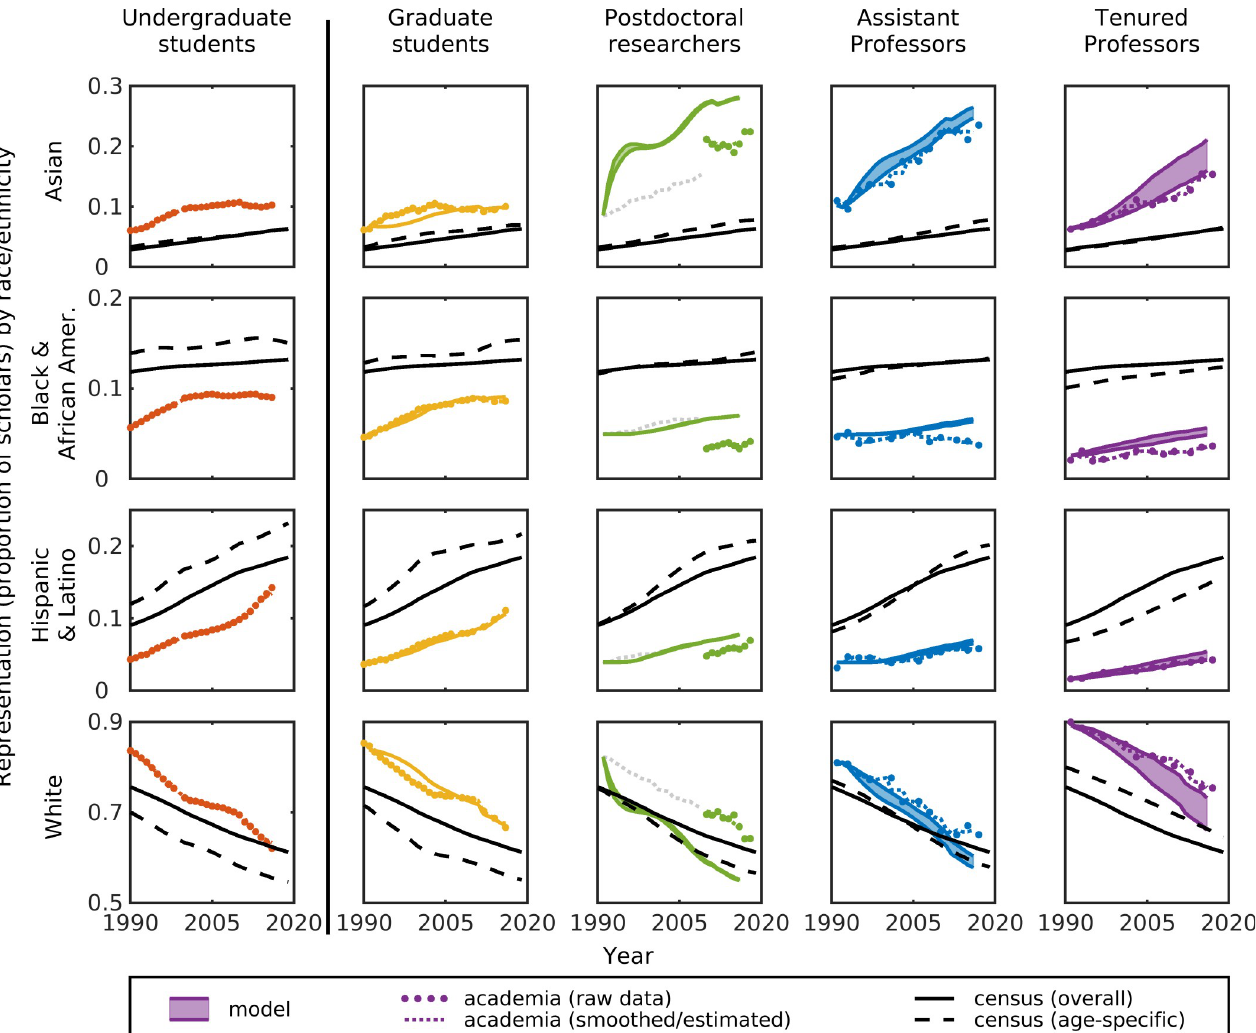
Fig 2. Scholar representation over time. The representation (i.e., the proportion of scholars in that stage that identify as that race or ethnicity) of the four largest American race/ethnicity categories (rows) in each academic stage (columns) over time comparing: null model predictions (colored solid lines), academia data (dots are raw data, dotted lines are smoothed data), and census data for the U.S. overall population (black solid lines) and US age-specific population (black dashed line). Mismatch between model and academia data indicate race/ethnicity-based biases of retention within academia, mismatch between model and census indicates race/ethnicity-based biases in recruitment into academia. Postdoc data before 2010 were unavailable, were estimated as the average of the graduate student and assistant professor data, and are greyed out in the figure. (See S7 Fig for additional race/ethnicity categories).